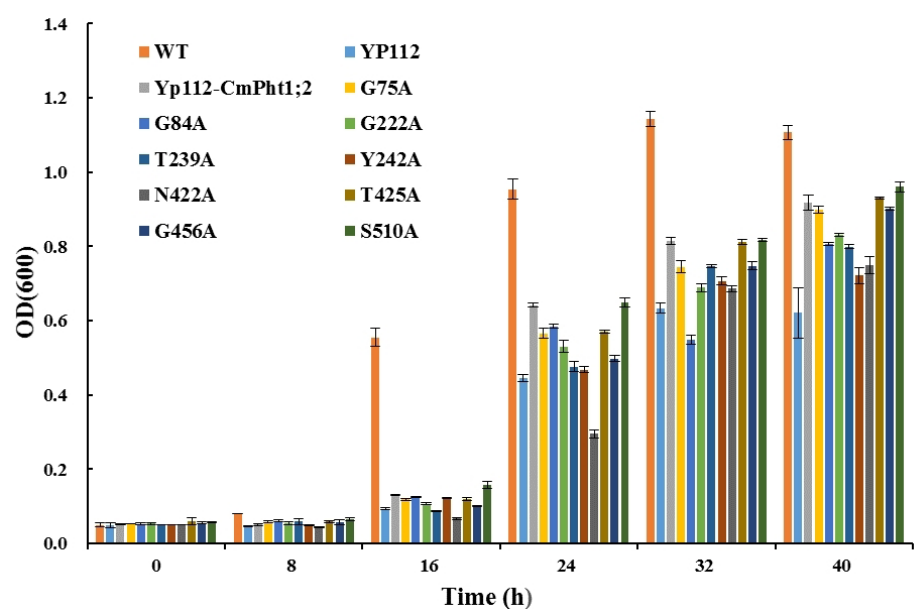
Figure 3. Growth rate of MB192 with CmPT2 and Cmphts expression growing in YNB medium with 60 μM Pi.